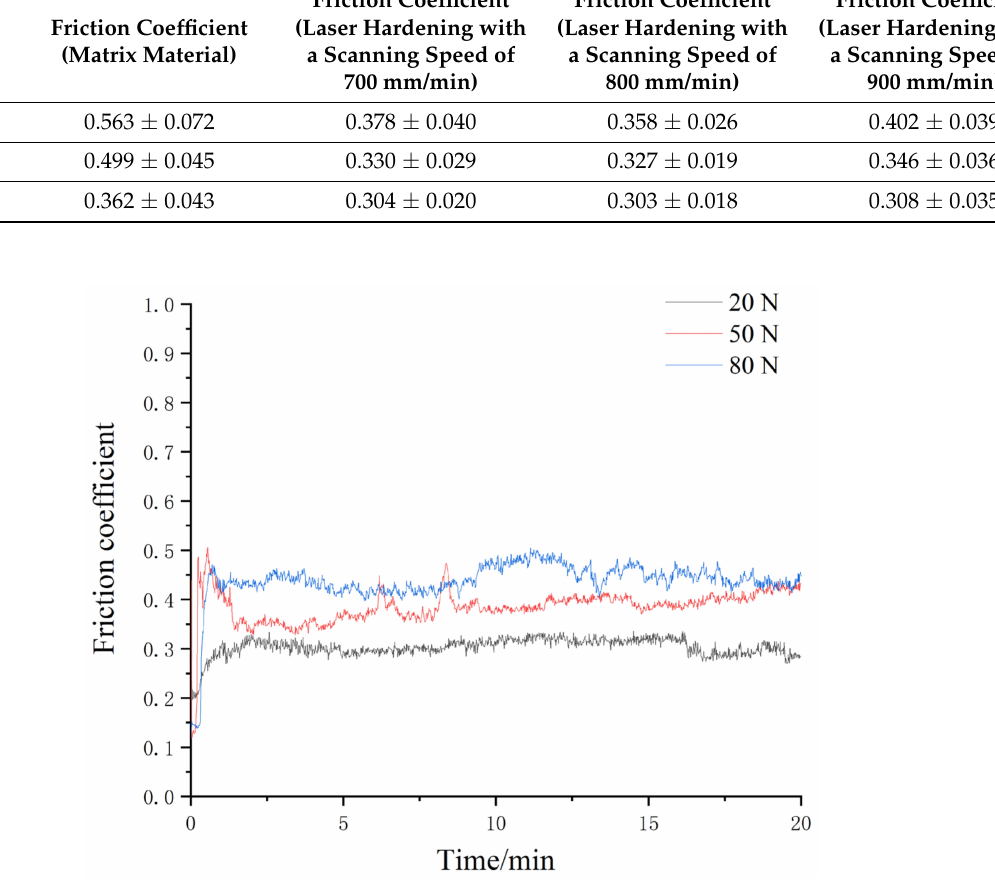
Figure 22. Friction coefficient of laser hardened layer under different relative normal force